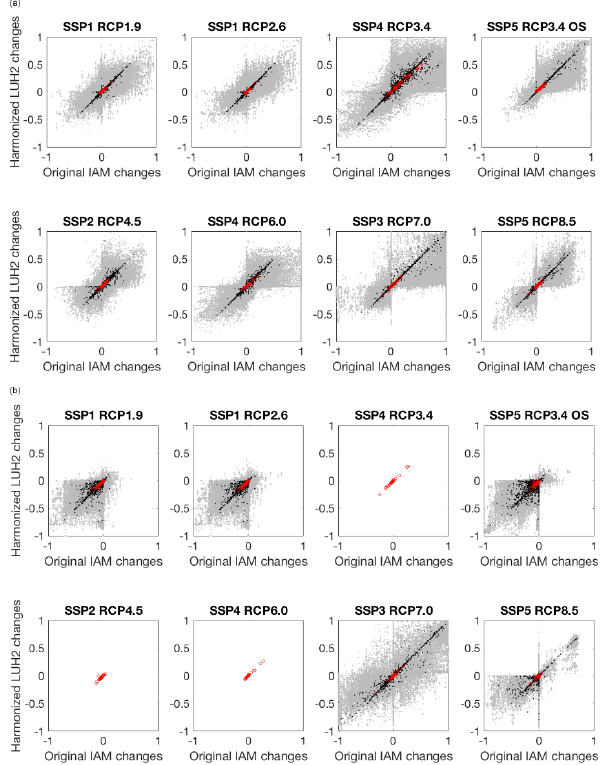
Figure 5. Post-harmonization comparison of projected changes for 2015–2100 at multiple scales: 0.25 ◦ (grey), 2 ◦ (black), and regional (red) as a fraction of total area. Original IAM change ( x axis) and harmonized change ( y axis) for (a) cropland and (b) grazing land. Note that for SSP4-RCP3.4, SSP2-RCP4.5, and SSP4-RCP6.0, pas- ture was only reported by IAMs as regional totals, so LUH2 com- parisons at 0.25 ◦ and 2 ◦ are not